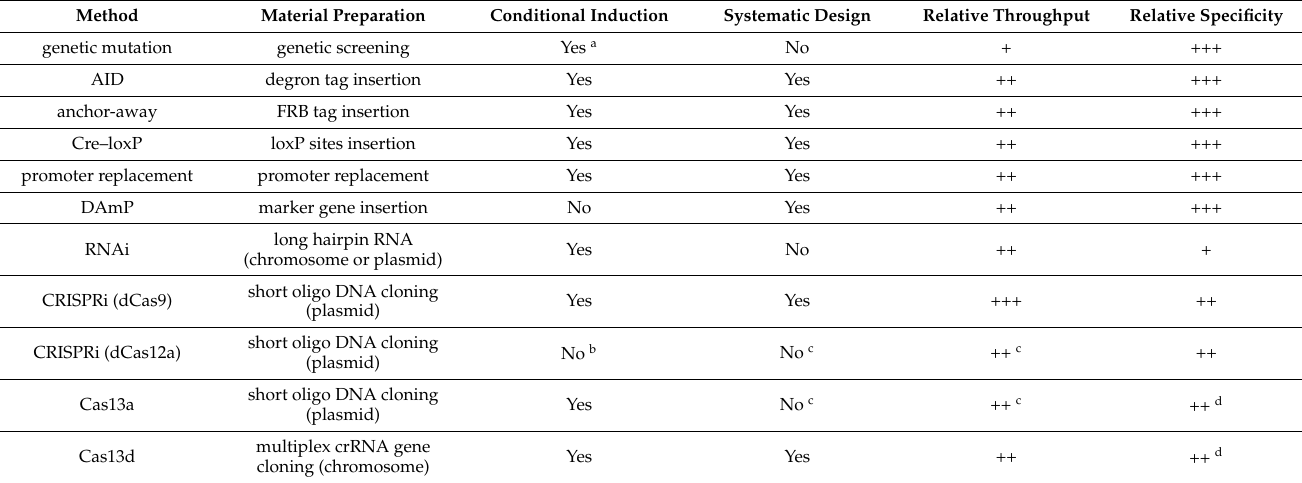
Table 1. Comparison of gene perturbation methods implemented in S. pombe